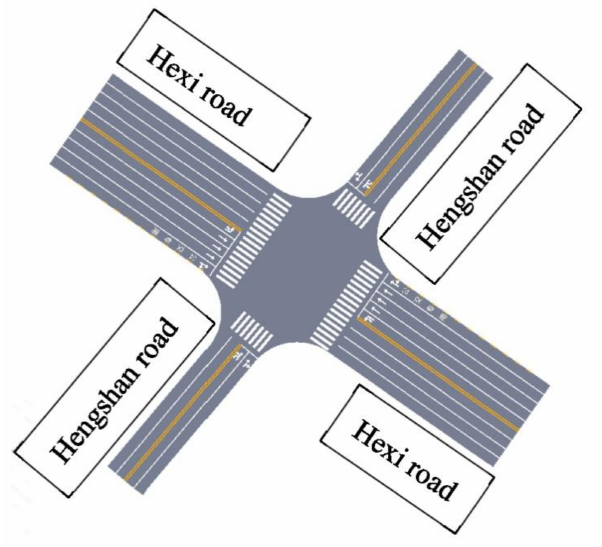
Figure 5. The junction of HeXi road and HengShan